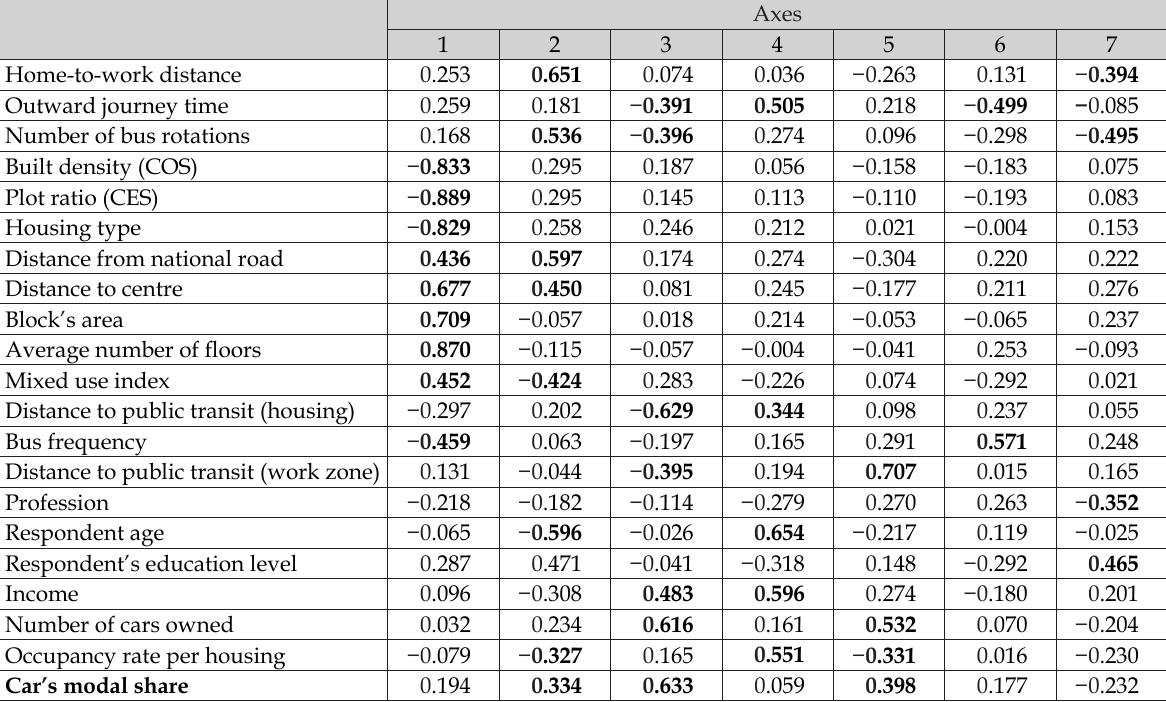
Table 4. Projection of variables in PCA